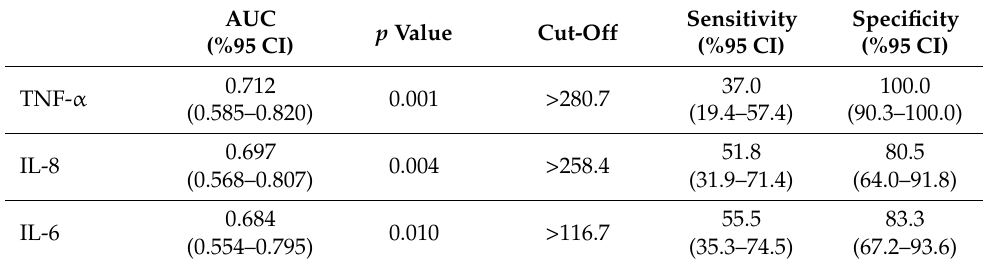
Table 3. ROC analysis demonstrating cut-off values of cytokines associated with